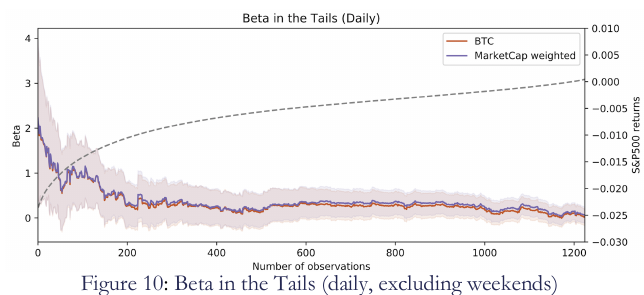
Figure 10: Beta in the Tails (daily, excluding weekends) Notes: Calculated based on daily returns from April 2013 to Feb